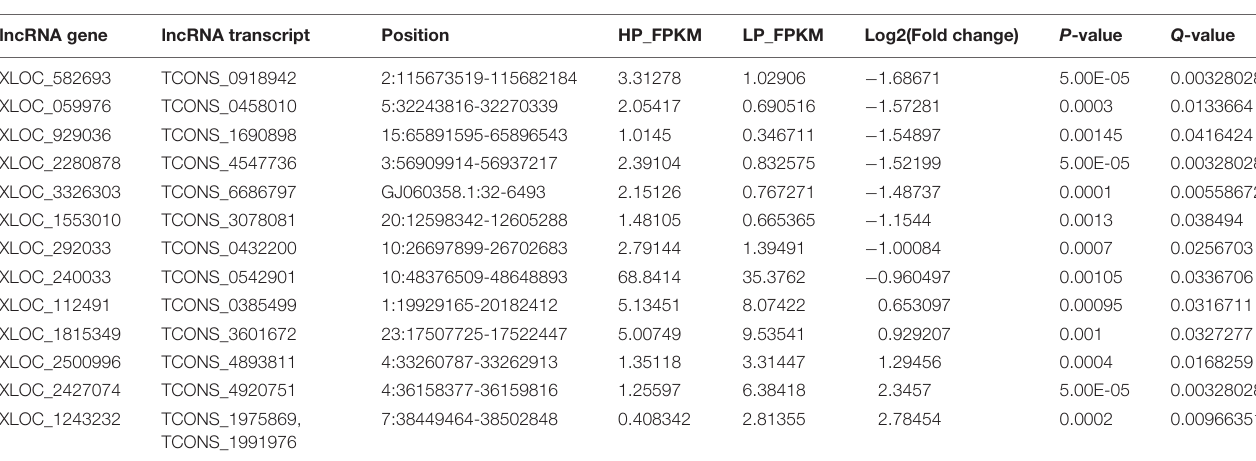
TABLE 2 | The differential lncRNAs expressed in both HP and LP